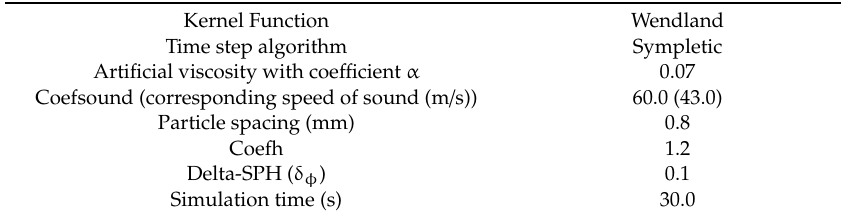
Table 3. Computational settings for DualSPHysics.